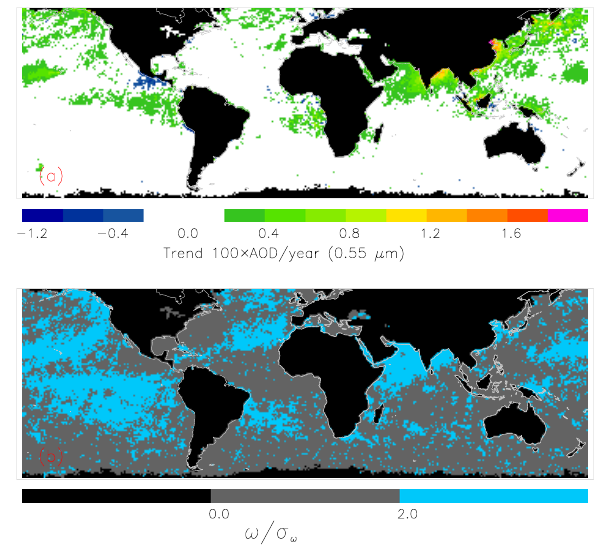
Fig. 10. (a) Similar to Fig. 7a, but the spatial distribution of 10- year trend of the anthropogenic AOD. The 1 × 1 ◦ (Lat/Lon) aver- aged MODIS Collection 5 aerosol product was used. (b) Spatial dis- tribution of the | ω / σ ω | values for every 1 × 1 ◦ (Lat/Lon) estimated using the same data as used in